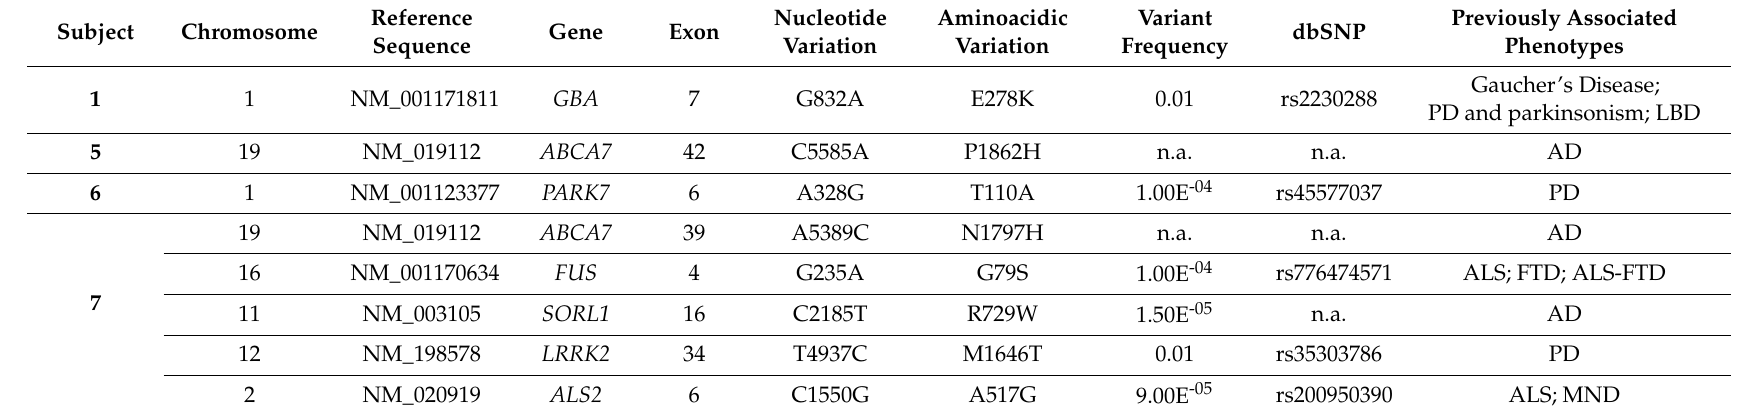
Table 2. Genes and rare variants identified in